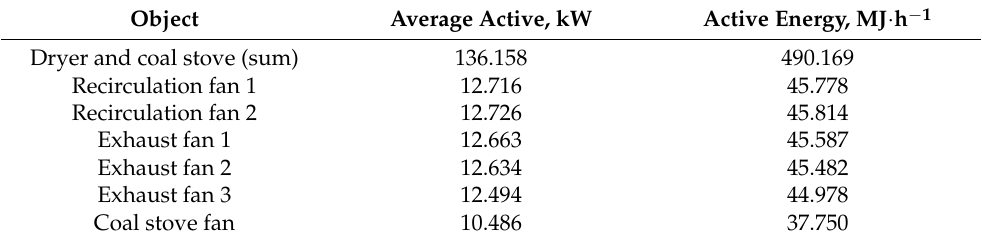
Table 5. Electrical parameters of individual components of the DT2532